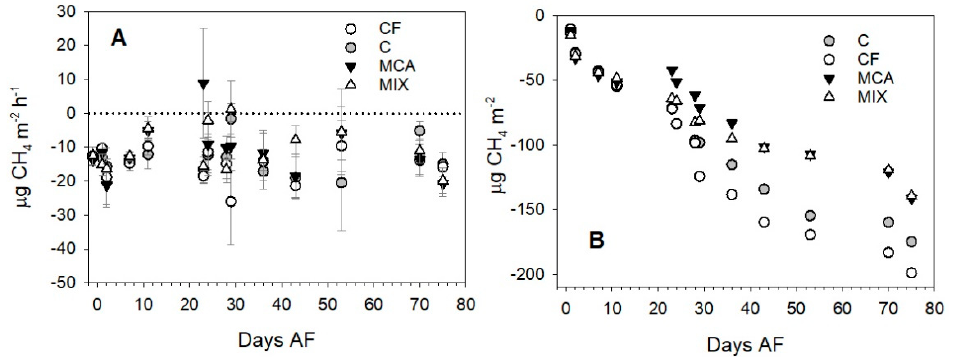
Figure 5. CH 4 hourly flux ( A ) and cumulative flux ( B ) measured in the plots of the four treatments between 14 May and 25 July 2013. DAF stands for days after fertilization event (13 May 2013). Error bars represent one standard deviation (n = 8).